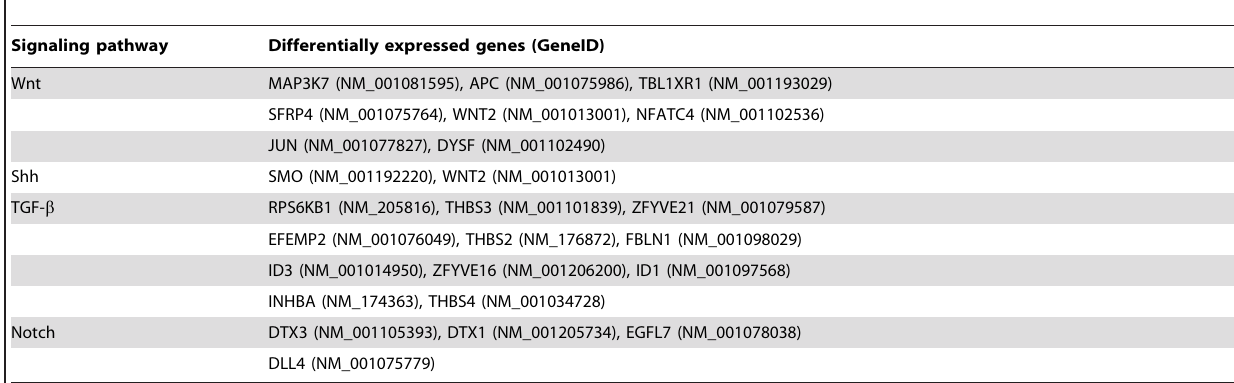
Table 3. List of possible signaling pathways and genes involved in cashmere goat hair follicle development and cycling.